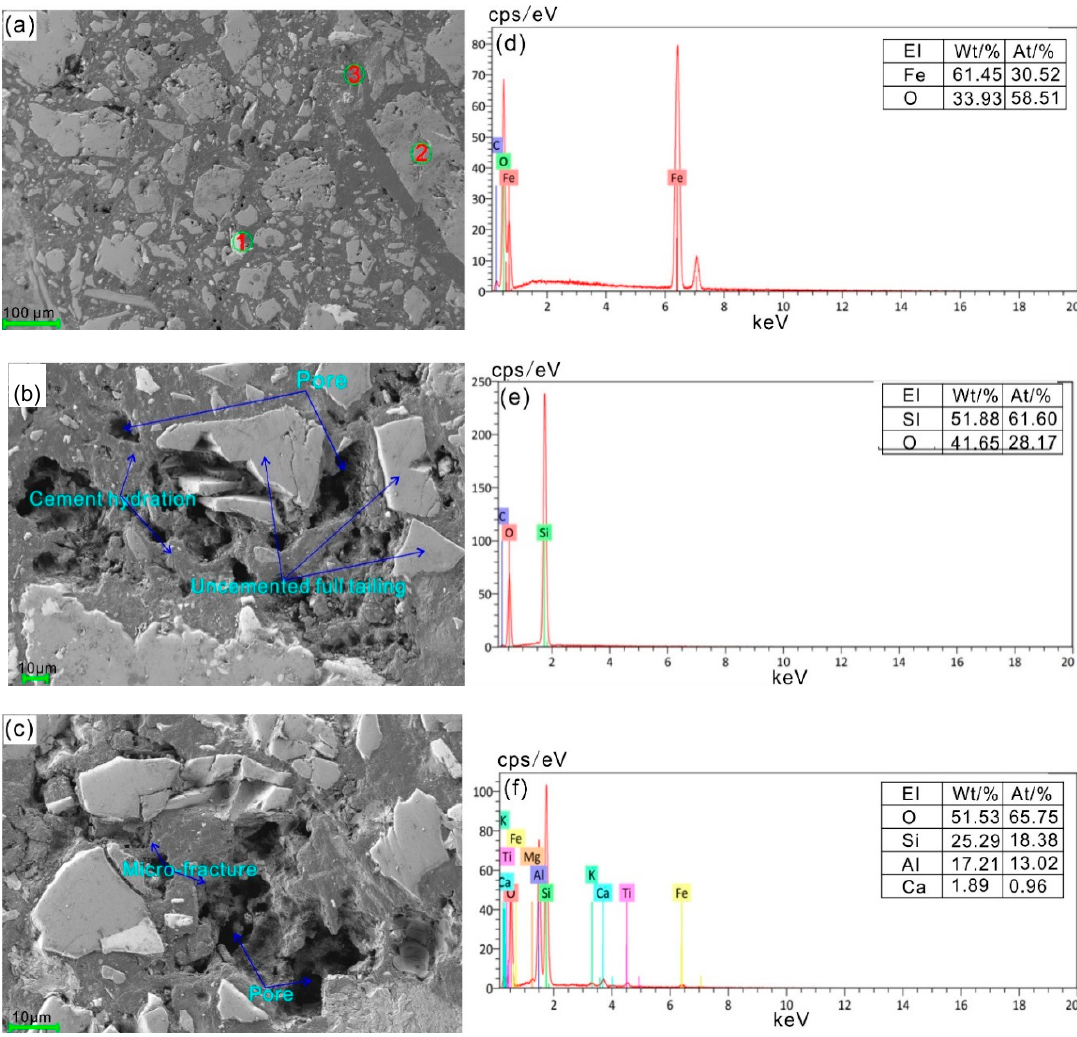
Figure 4. Scanning electron microscope (SEM) results for the cemented tailing paste ( a – c ): the magnification is 129, 627, and 1000 times, respectively; ( d – f ): for the three points on Figure 4a).